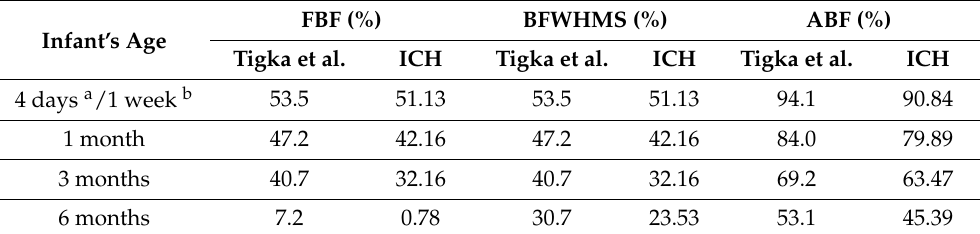
Table 4. Breastfeeding indicators per time period (%). Comparison with National Study 2017